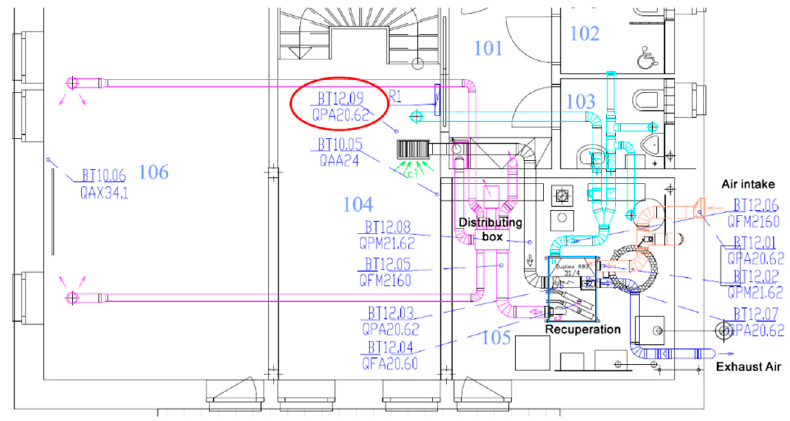
Figure 5. The ground plan of the ground floor of the SH with the location of the sensors for CO 2 measurement.